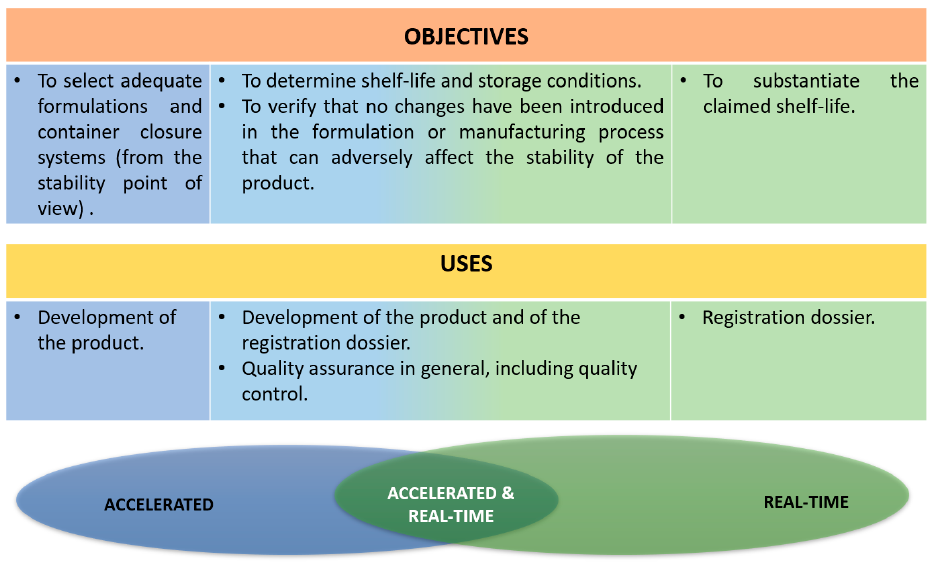
Figure 4. Objectives of Stability Testing. Adapted from: [8].